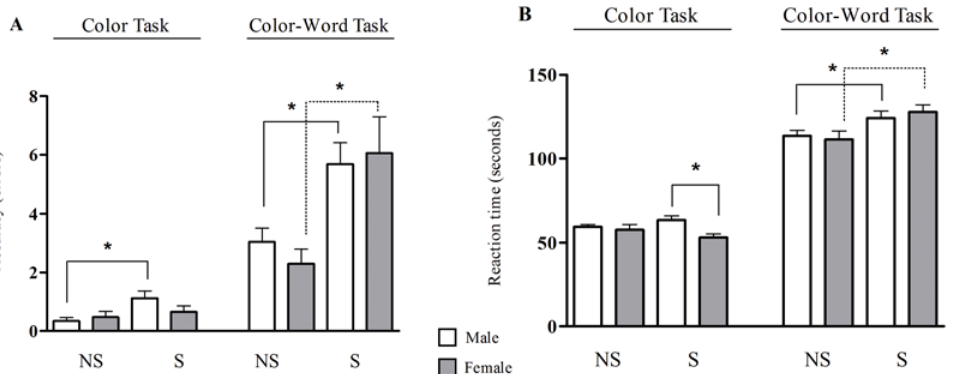
Fig 3. Cognitive performance of non-stressed (NS) and stressed (S) subjects during the Stroop test. A. Accuracy of response in Color task and Color- Word task of Stroop test in male and female subjects. B. Reaction time in both tasks of the Stroop test in male and female subjects. ( * ) Indicates significant differences, p (cid:1) 0.05 (One-way